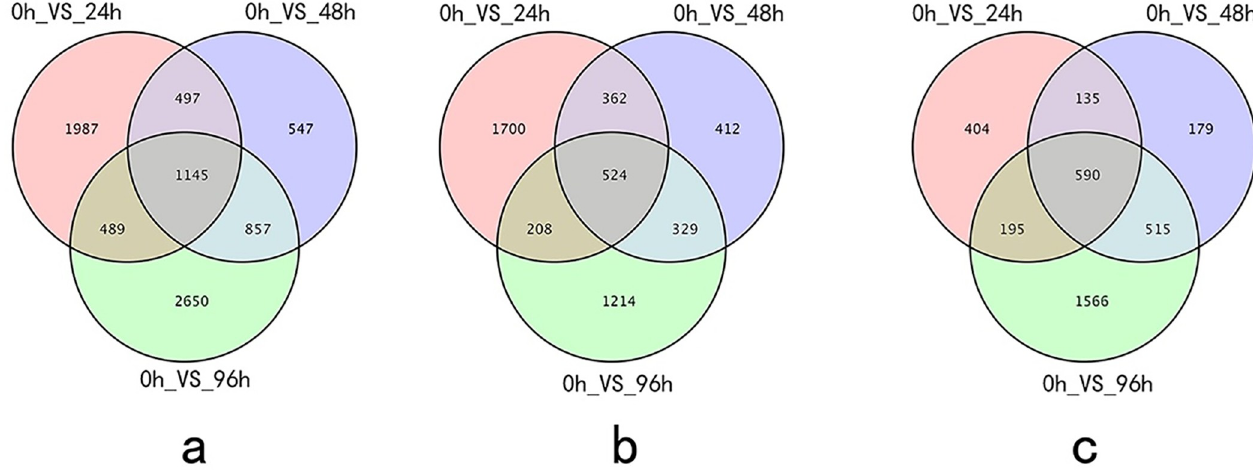
Fig 2. Drought-induced, differentially expressed genes in Larix olgensis . (a) Venn map of differentially expressed genes after 24 h, 48 h, and 96 h under drought stress; (b) Venn map of genes that were only up-regulated after 24 h, 48 h, and 96 h under drought stress; (c) Venn map of genes that were only down- regulated after 24 h, 48 h, and 96 h under drought